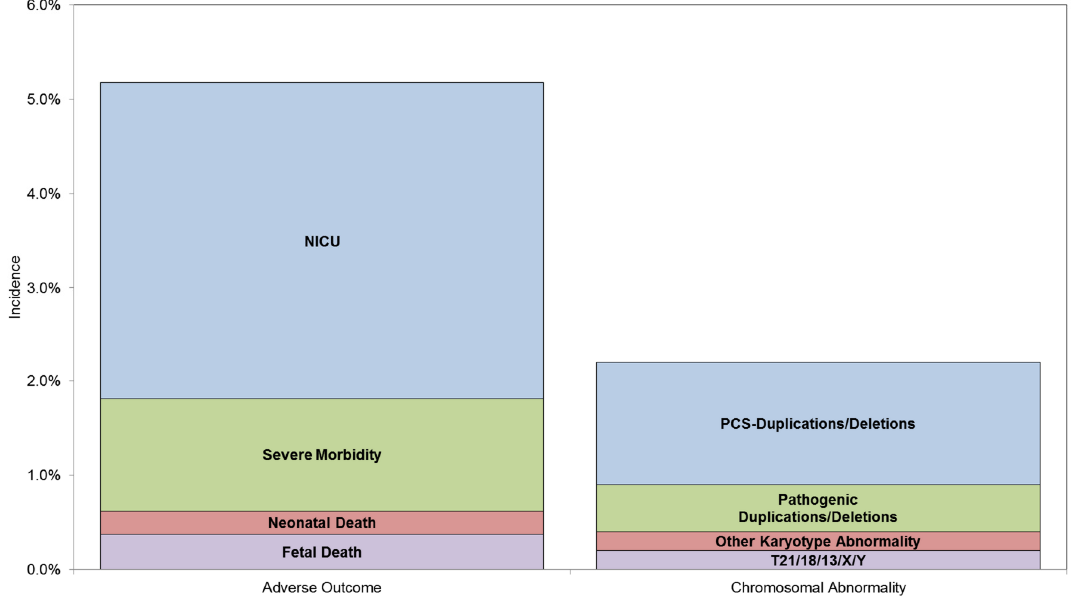
Figure 1. Comparison of incidence of adverse outcomes due to all causes with incidence of chromosomal abnormality. Data for incidence of adverse outcome from Lisonkova et al. [35]. Data for incidence of chromosomal abnormality from Wapner et al. [36]. NICU = Infant admitted to neonatal intensive care unit, PCS-Duplications/Deletions = Chromosome microdeletions and duplications with potential for clinical significance, T21/18/13/X/Y = trisomy 21, trisomy 18, trisomy 13 and sex chromosome